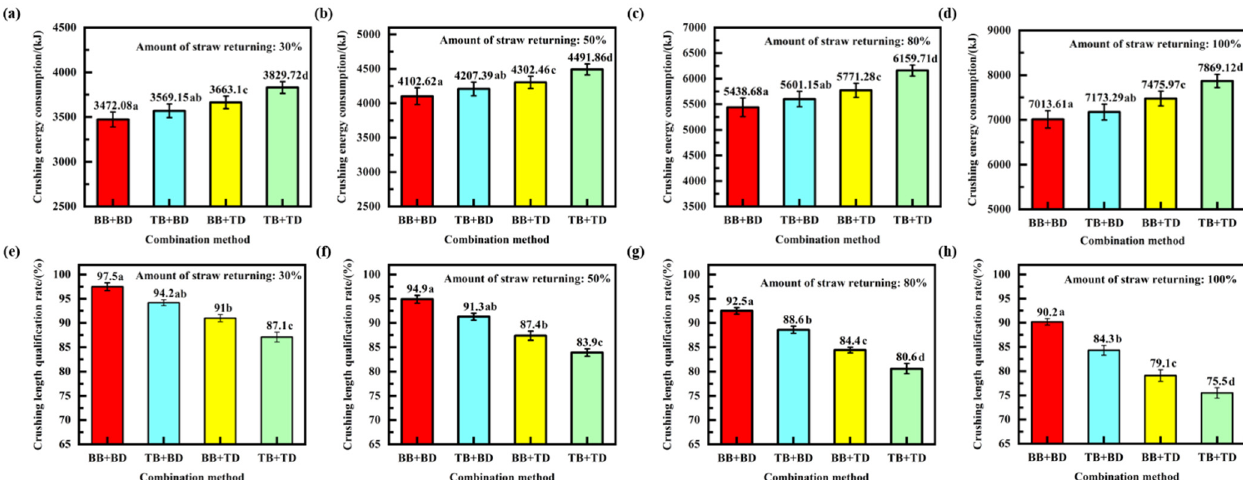
Figure 5. Parameter optimization test results. ( a ) Effect of different mechanism collocation methods on operating power consumption at 30% of straw returning amount. ( b ) Effect of different mechanism collocation methods on operating power consumption at 50% of straw returning amount. ( c ) Effect of different mechanism collocation methods on operating power consumption at 80% of straw returning amount. ( d ) Effect of different mechanism collocation methods on operating power consumption at 100% of straw returning amount. ( e ) Effect of different mechanism collocation methods on crushing length qualification rate at 30% of straw returning amount. ( f ) Effect of different mechanism collocation methods on crushing length qualification rate at 50% of straw returning amount. ( g ) Effect of different mechanism collocation methods on crushing length qualification rate at 80% of straw returning amount. ( h ) Effect of different mechanism collocation methods on crushing length qualification rate at 100% of straw returning amount. Averages followed by different lowercase letters are significantly different according to LSD’s multiple range experiment at the significance level of 0.05. Error bars are standard deviation.